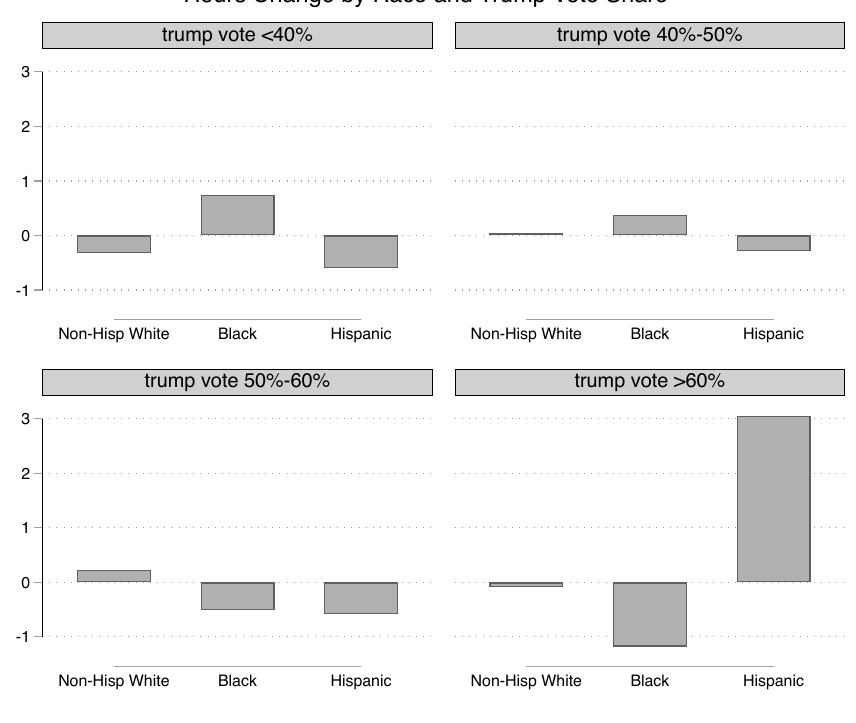
Figure 2: Weighted mean year-over-year change in weekly work hours among hourly workers, November 2015 to March 2017. Notes: This figure shows survey-weighted mean changes in year-over-year weekly work hours within analytic sample of prime-age hourly workers employed in the same job from November 2015 to March 2017. N = 15, 962 person–week observations (7,981 year-over-year spans).